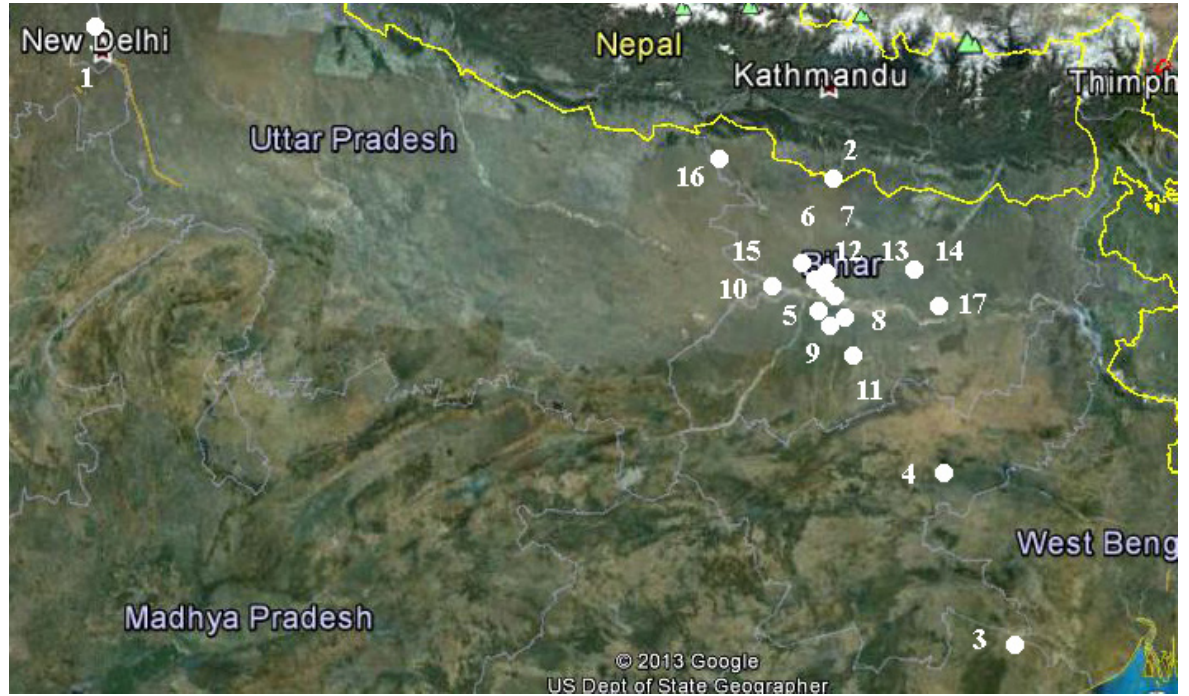
Figure 1. Map of sampling sites in the Gangetic plains of India and Nepal